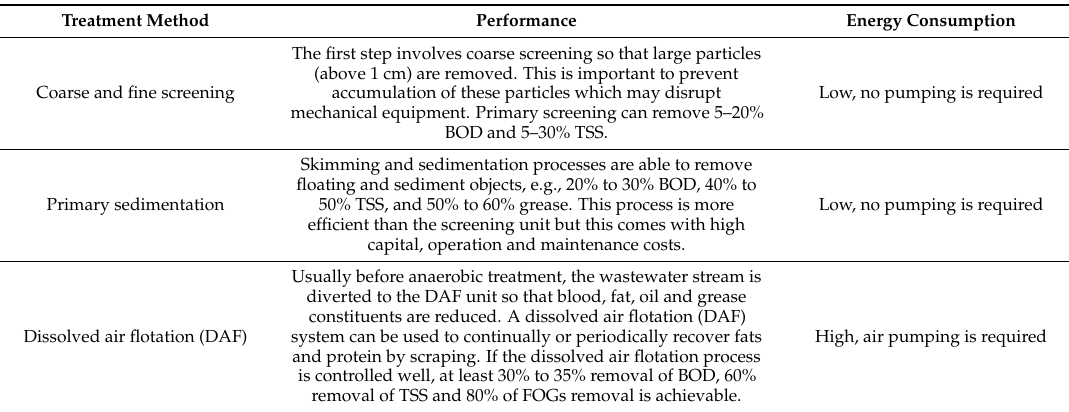
Table 7. Physical treatment methods and their performance [18,19].